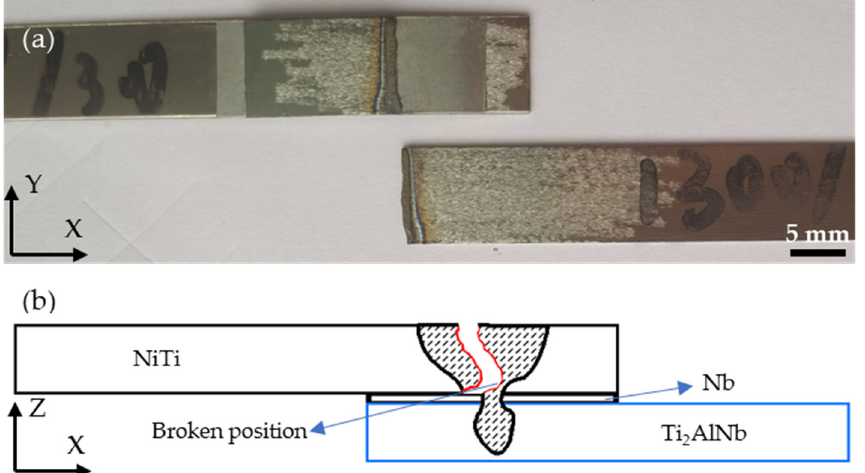
Figure 10. Fracture mode II: ( a ) Tensile fracture specimen; ( b ) Schematic diagram of fracture (The red line indicates the fracture surface).